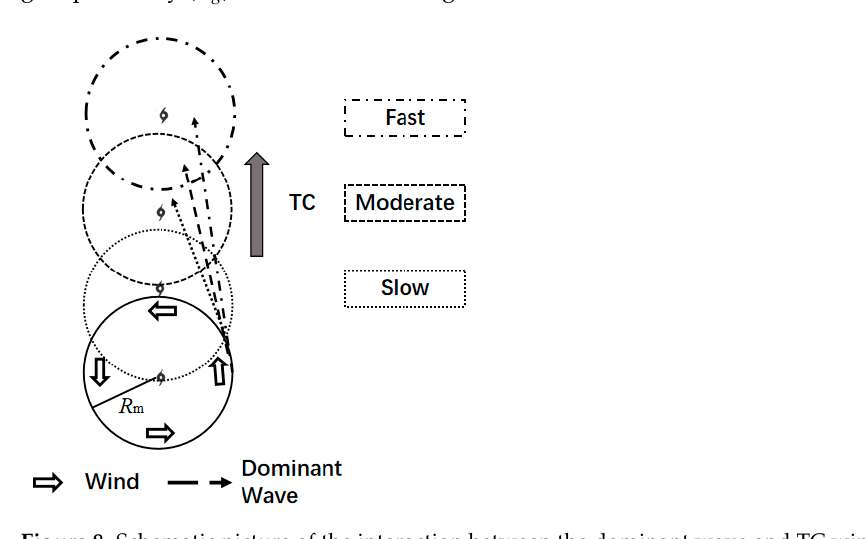
Figure 8. Schematic picture of the interaction between the dominant wave and TC wind correspond- ing to different translation speeds (slow, moderate and fast).